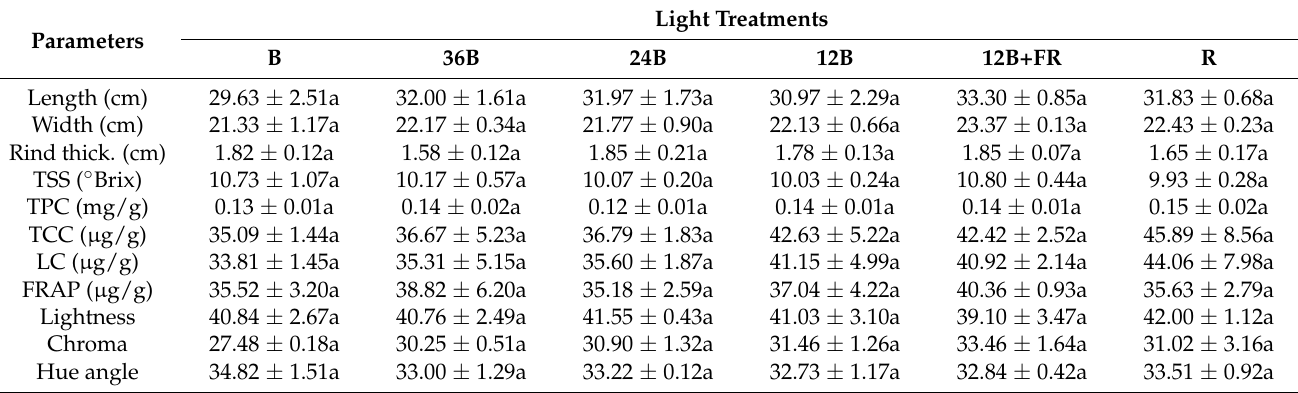
Table 4. Morphological, phytochemical, and colorimetric parameters of ripe watermelon fruits after field cultivation in 2019. The transplanted grafted seedlings were treated with six different light treatments during the healing stage. TSS: total soluble solids; TPC: total phenolic content; TCC: total carotenoid content; LC: lycopene content; FRAP: ferric reducing antioxidant power. Color was measured in the center of the fruit. Mean values ( ± SE) within a parameter followed by different letters are significantly different (a <